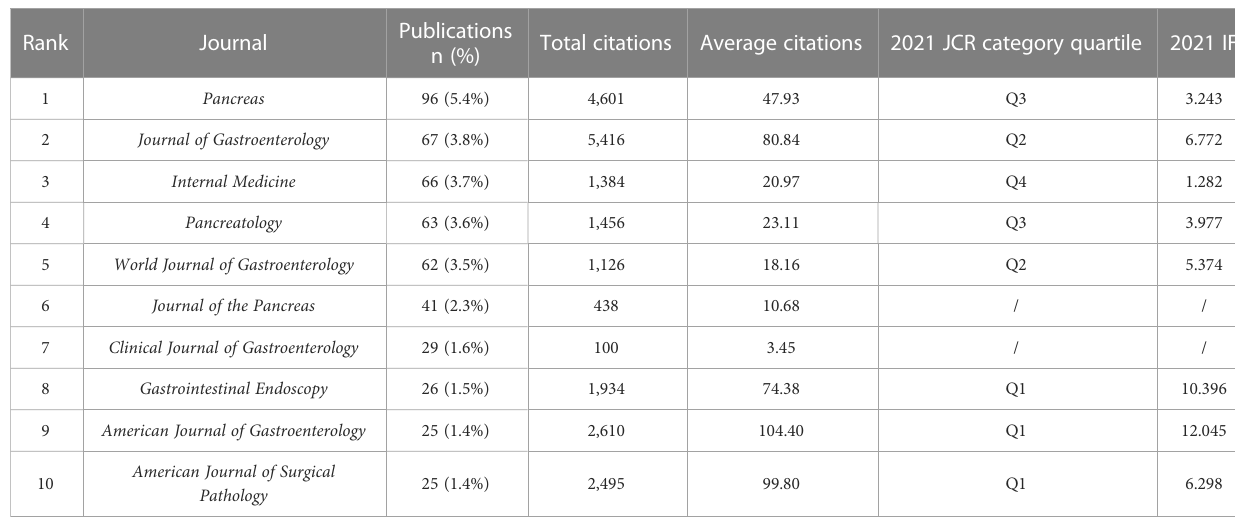
TABLE 4 The top 10 core journals in terms of AIP research.